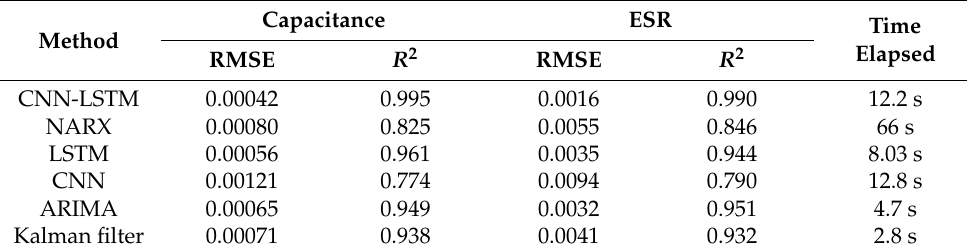
Table 2. CNN-LSTM performance and comparison with other